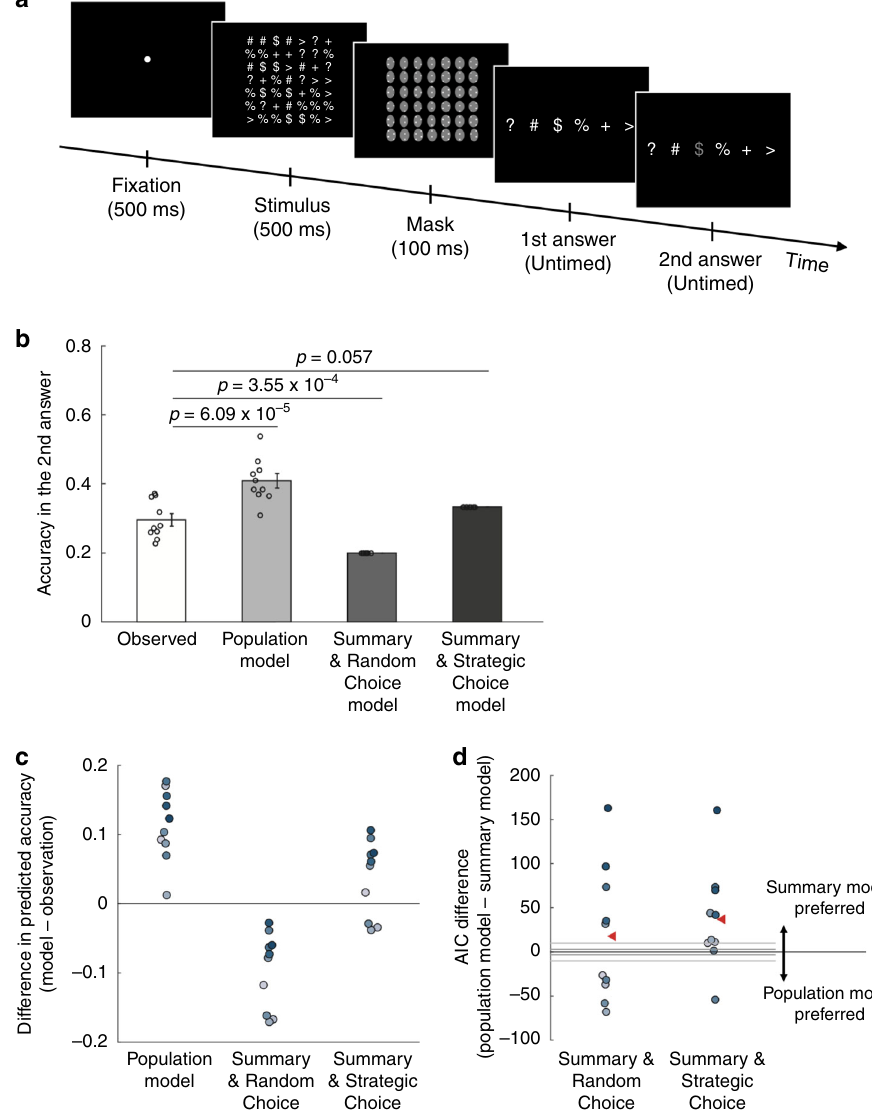
Fig. 6 Task and results for Experiment 3. a The same stimuli as in Experiment 2 were used in Experiment 3 but the task was slightly different. Subjects always reported the dominant symbol among all six alternatives. However, on 40% of the trials in which they gave a wrong answer, subjects were given the opportunity to make a second guess. b Mean accuracy for the second answer observed in the actual data (white bar), predicted by the population model (light gray bar), predicted by the Summary & Random Choice model (dark gray bar), and predicted by the Summary & Strategic Choice model (black bar). The predictions of the three models were derived based on subjects ’ fi rst answers. All p values are derived from two-sided paired t tests. Error bars represent SEM, n = 10. c Individual subjects ’ differences in the accuracy of the second answer between each model ’ s prediction and the observed data. d AIC difference between the population and the two summary models. Positive AIC values indicate that the summary model provides a better fi t to the data. Each dot represents one subject. The red triangle indicates the average AIC